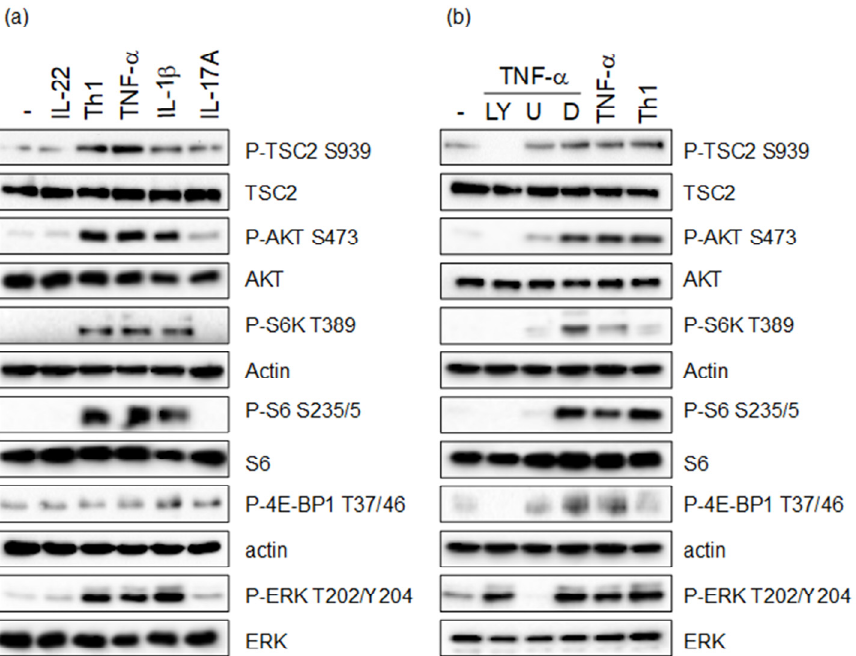
Figure 1. ( a ) HaCaT cells were starved overnight and stimulated with the indicated cytokines (20 ng/mL) or a mix of Th1 cytokines (IL-1 β , IL-17A and TNF- α ; 20 ng/mL each) for 30 min. ( b ) HaCaT cells were starved overnight and treated for 30 min with the indicated inhibitors (L = 50 µ M LY294002; U = 10 µ M U0126; D = DMSO), followed by stimulation with 20 ng/mL TNF- α or the Th1 mix (20 ng/mL each). Protein lysates were prepared and analyzed by Western blotting with the indicated antibodies. Equal protein loading was confirmed using total protein antibodies